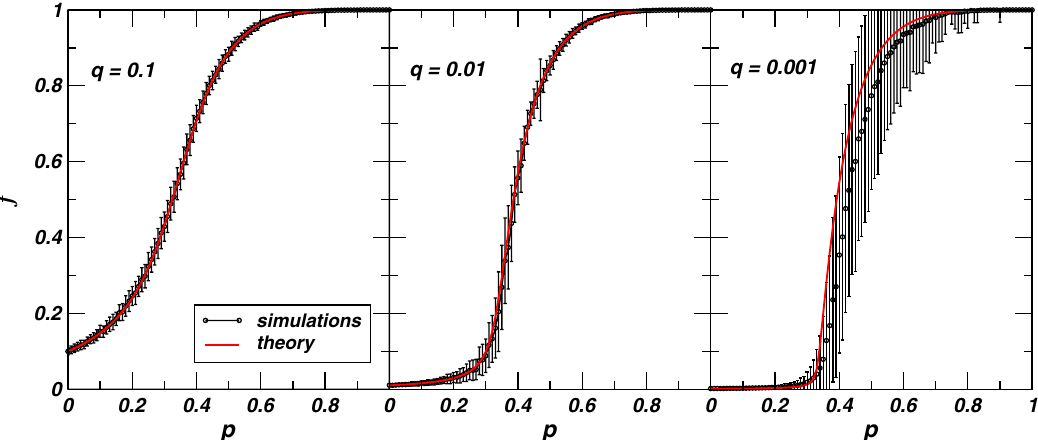
FIG. 1. Black circles represent the average density f of nodes that have been infected by the final (infinite) time in the SIR dynamics on a random regular graph of N ¼ 10 3 nodes and degree K ¼ 4 , as a function of the transmission probability p for q ¼ 0 . 1 , 0.01, 0.001 (from left to right). The symmetric bars indicate the fluctuations around the average value computed on 10 4 realizations of the stochastic process. The red solid line is computed from the solution of Eqs. (2) and